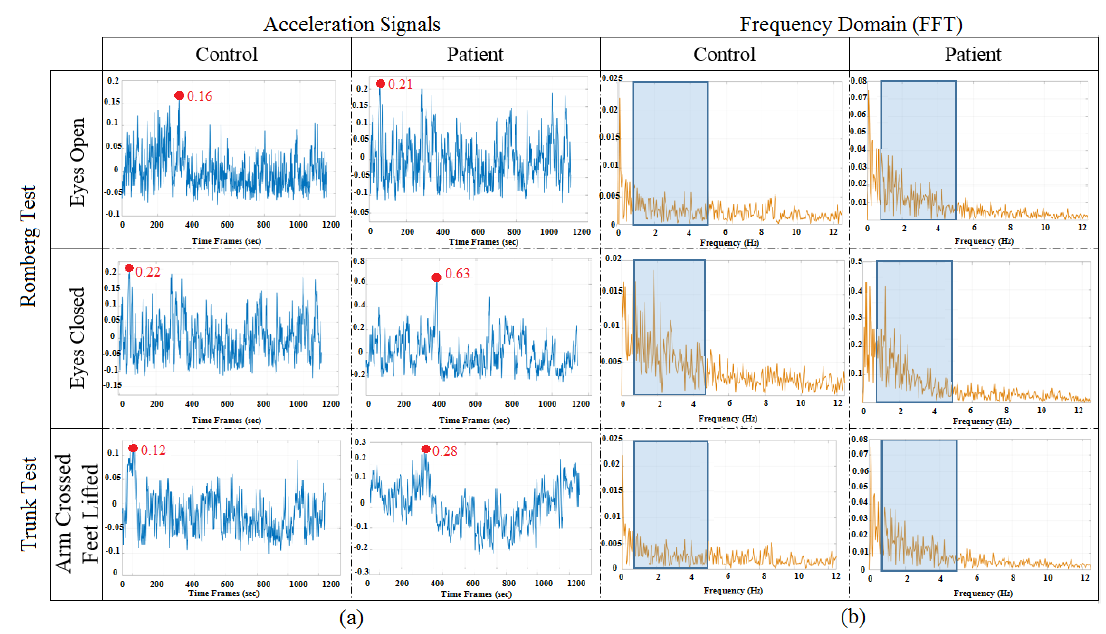
Figure 2. ( a ) Magnitude of the measured accelerations and ( b ) signal frequency bands